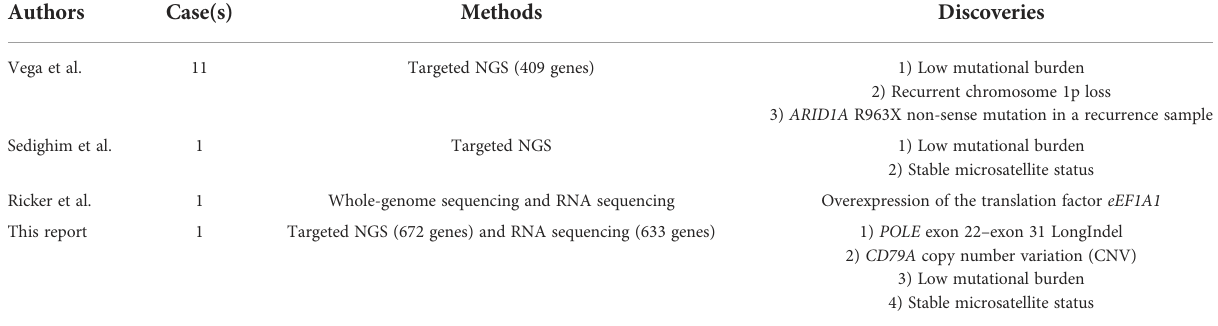
TABLE 1 The summary of studies about next-generation sequencing (NGS) of CIC – DUX4